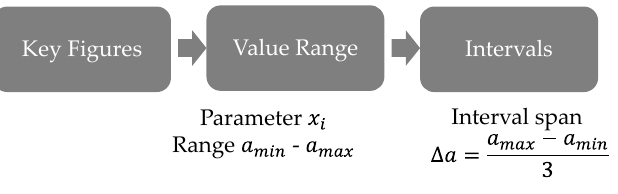
Figure 3. Procedure for classification.